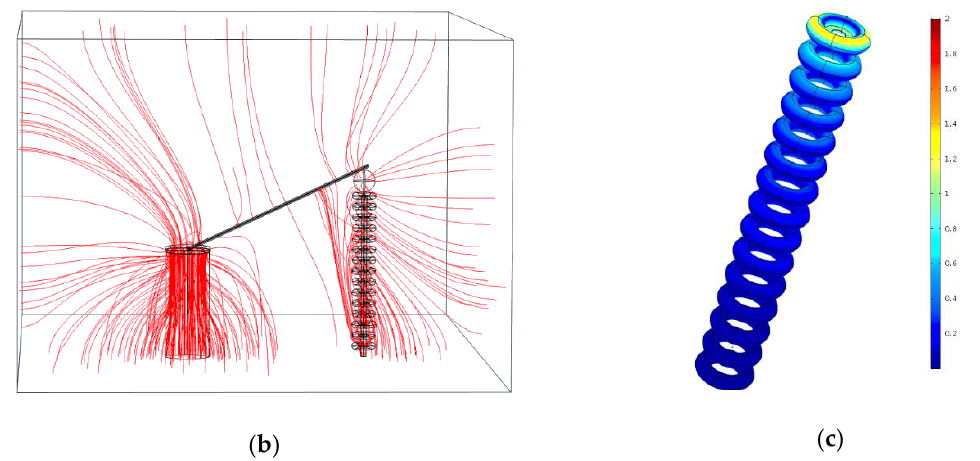
Figure 10 . Grading rings added to the resistive high-voltage divider to minimize the effects of the stray capacitance. ( a ) Voltage distribution along the high-voltage arm of the divider, ( b ) Streamline plot of the electric field lines around the divider, ( c ) Electric field strength on the surface of the cylindrical protection at 130 kV RMS.